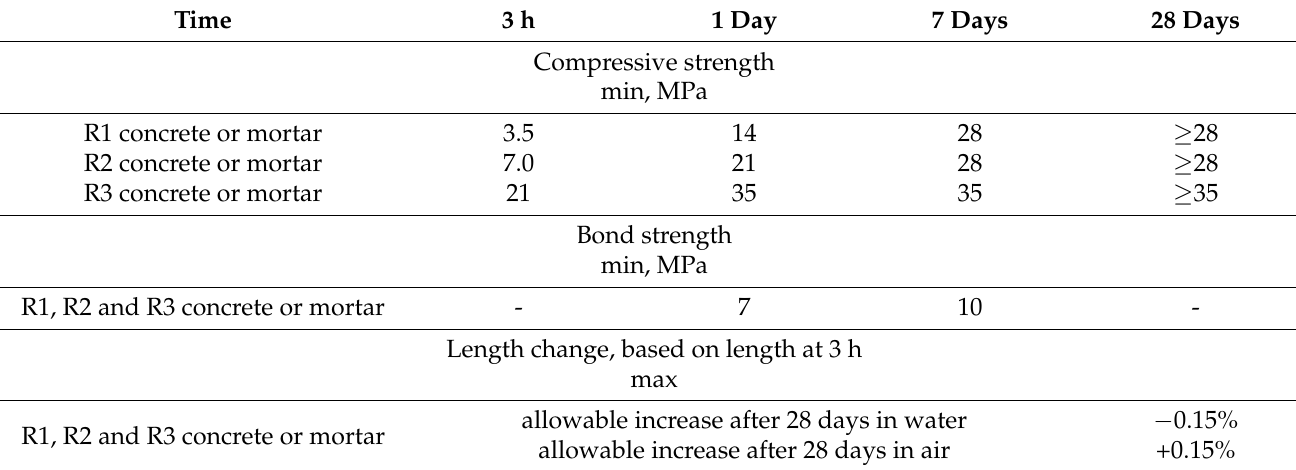
Table 3. American standard (ASTM) for performance requirements for repair products